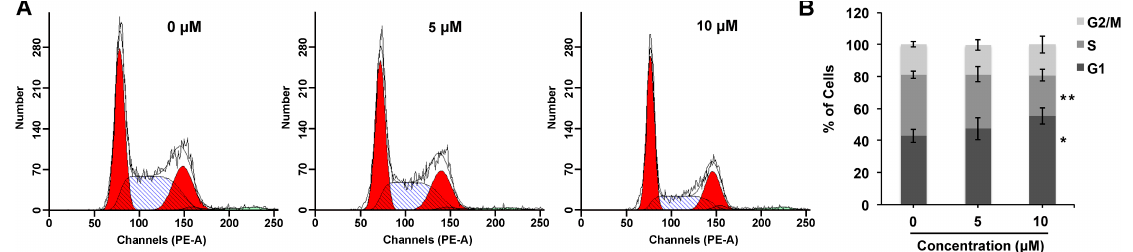
Figure 4. Compound 1 induced G1 phase cell cycle arrest in ovarian cancer cells. ( A ) A2780 cells were treated with indicated concentrations of compound 1 for 24 h. Cell cycle assays were conducted using flow cytometry; ( B ) The fractions of cells at the G1, S and G2/M phases were semi-quantified. * p < 0.05 and ** p < 0.01, compared with the 0 µM compound 1 treatment (control).